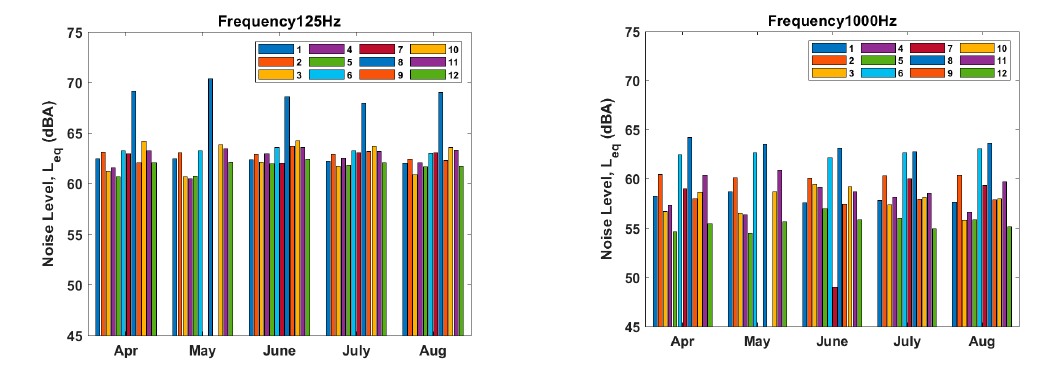
Figure 4. Average at 125 Hz and 1000 Hz in different months for different sensors.